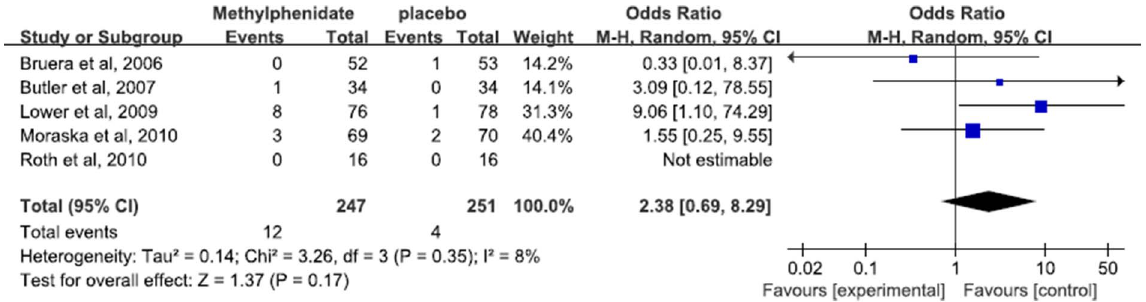
Figure 6. Forest plot shows the incidence of adverse effects in patients assigned to Methylphenidate versus placebo.